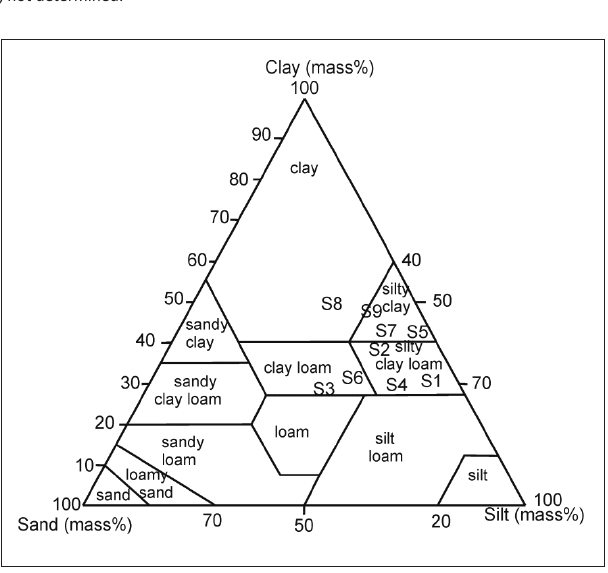
FIGURE 5: Textural classification of unconsolidated sediments from Dzanani.